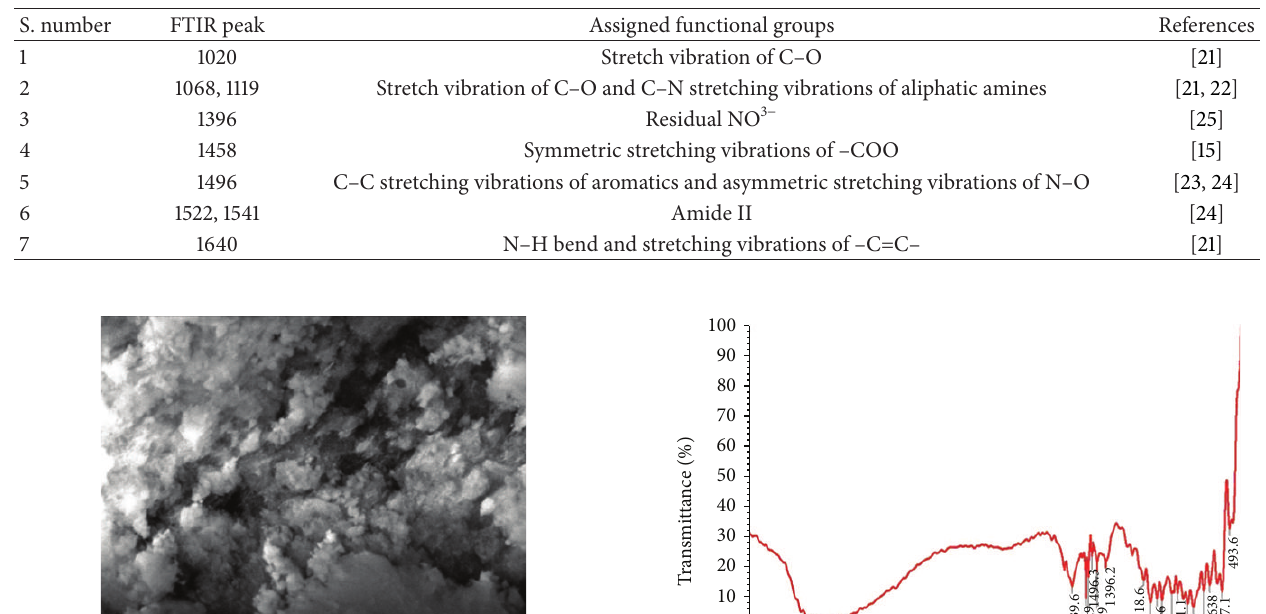
Table 1: FTIR peaks and their representative functional groups.